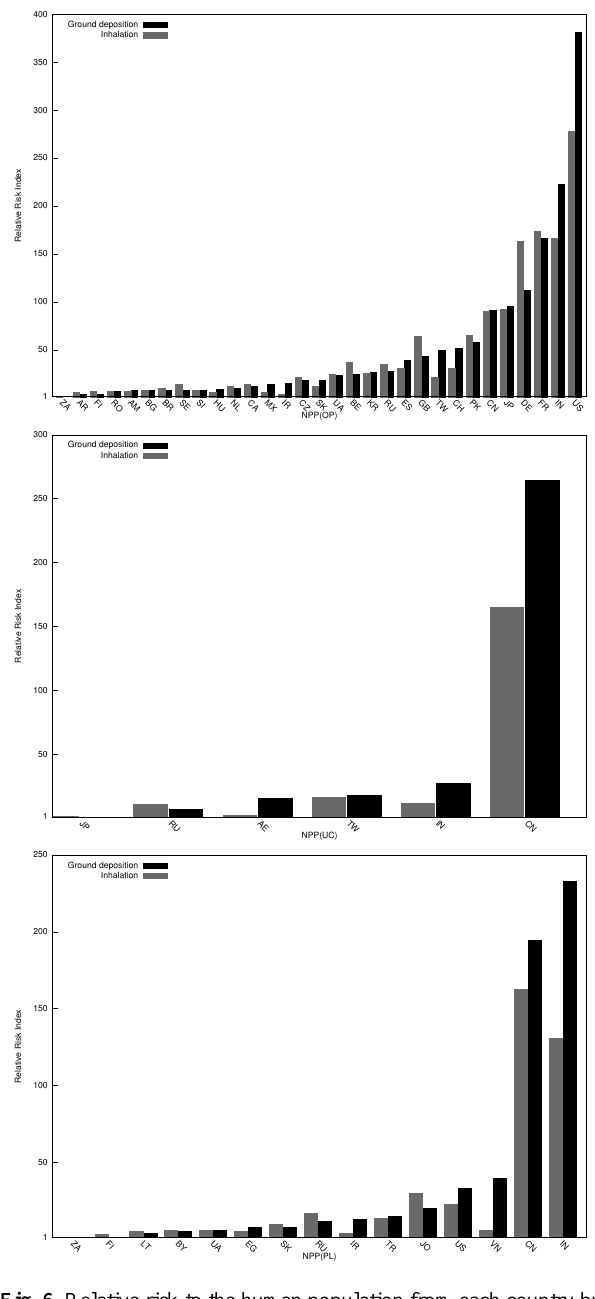
Fig. 6. Relative risk to the human population from each country by nuclear power plants in operation (top), under construction (bottom- left), and planned or proposed (bottom-right) calculated by integrat- ing the product of the dose from ground deposition (black) and in- halation (grey), and human population density assuming unit PBq emission per station. Population projections by the UN for the year 2025 were used. Table 1 lists the country codes.